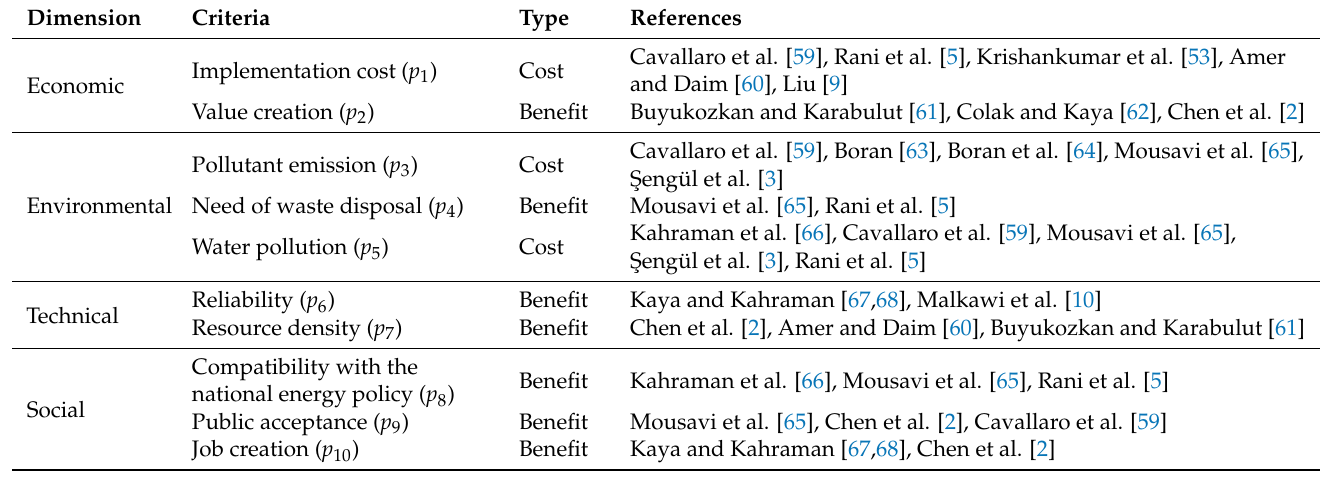
Table 2. Assessment criteria used in RESs selection.